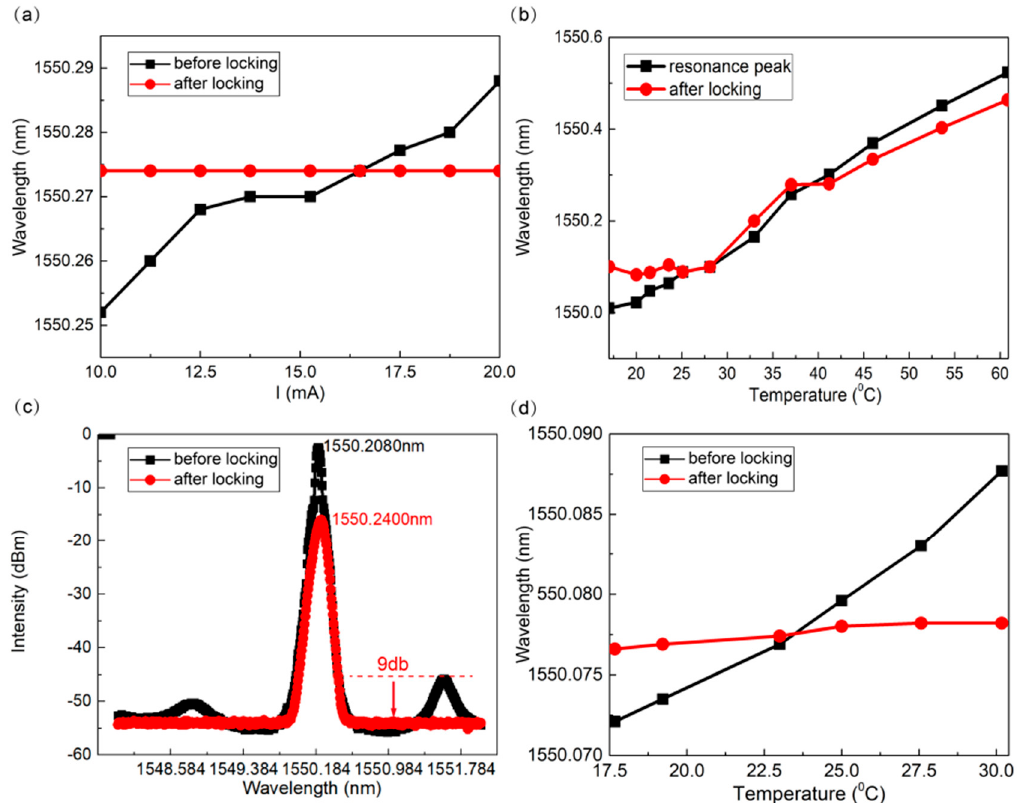
Figure 3. ( a ) Measured laser wavelength versus driving current before (black) and after (red) the self-injection locking. ( b ) Laser output wavelength of as a function the FPMC temperature (red) and that of FPMC resonance (black). ( c ) Measured laser spectrum before (black) and after (red) locking. ( d ) Laser output wavelength as a function of its case temperature.